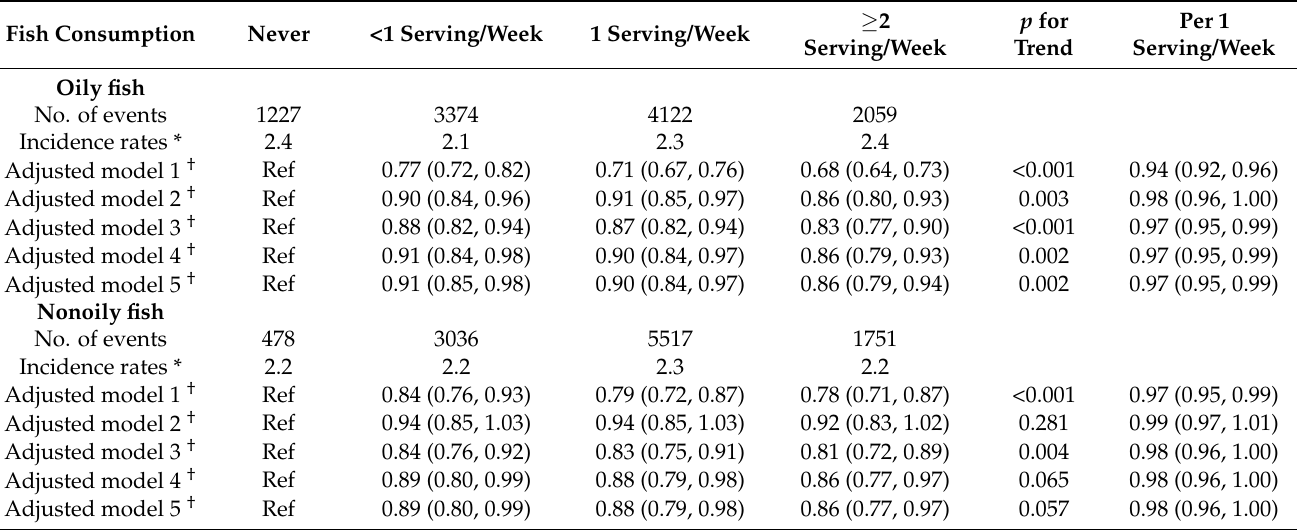
Table 2. The relationship between fish consumption with risk of incident chronic kidney